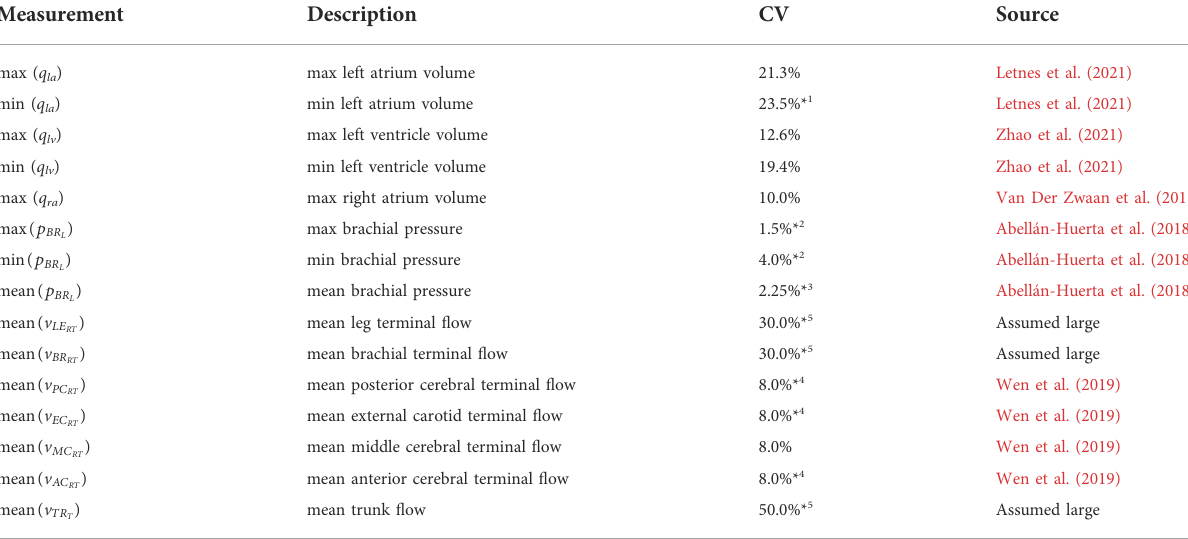
TABLE 2 Coef fi cient of variation (CV) for each measurement, with data sources. * 1 : taken from 3D RC%, * 2 : variability between measurements separated by 24 h, * 3 : estimated as average of max ( p BR L ) and min ( p BR L ) , * 4 : assumed to be the same as for MC, * 5 : non-crucial fl ow rates are assumed to have a high